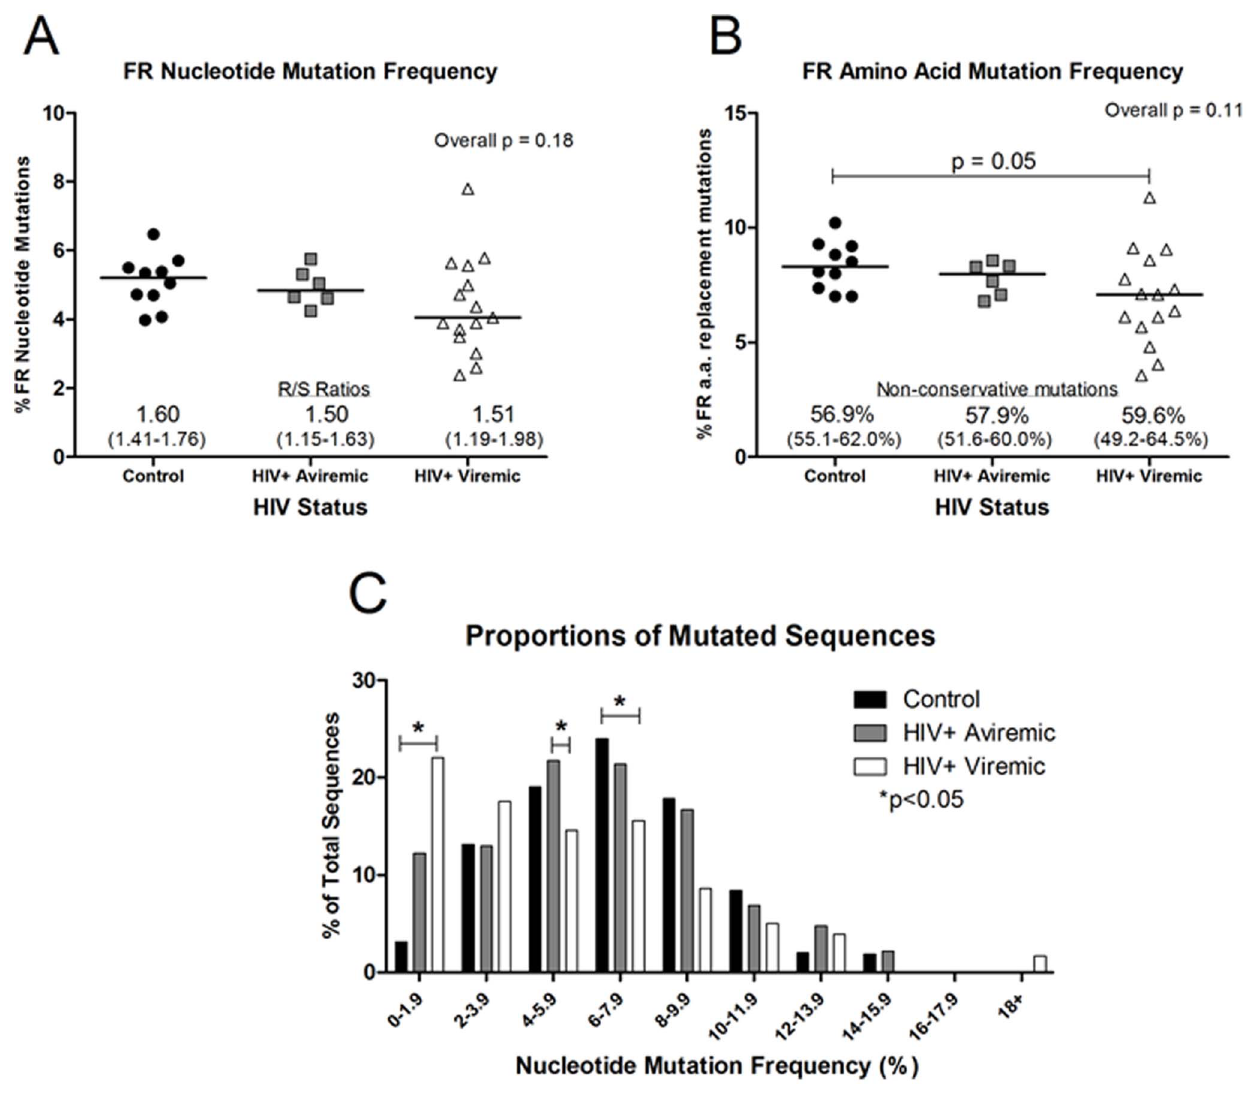
Figure 3. Amino acid mutation frequency is reduced in FR1/2/3 regions of viremic HIV-1-infected patients. The mean percent of mutated nucleotides or the mean percent of replaced amino acids was calculated for each control subject (n=10; black circles), aviremic patient (n=6; gray squares), or viremic HIV-1-infected patient (n=15; white triangles) based on the alignment of the cloned sequences with V H 3 sequences from the Vbase immunoglobulin database. The solid bar indicates the group median. A) The mean percent of mutated nucleotides in the FR1/2/3 regions. The median (and range) of R/S ratios indicates the number of amino acids replaced as a result of nucleotide mutations relative to unchanged (silent) amino acids (overall p=0.17). B) The mean percent of replaced amino acids in the FR1/2/3 regions. The median (and range) percent non- conservative mutations was calculated relative to the total number of replaced amino acid mutations (overall p=0.19). C) The proportion of sequences with low nucleotide mutation density is greater in viremic HIV-1-infected patients. The median proportion of sequences with specific nucleotide mutation density across the entire sequence is graphed by group (control=black bars, aviremic=gray bars, viremic=white bars). Overall p values 0–1.9%, p=0.02; 4–5.9%, p=0.04; 6–7.9%, p=0.04. Secondary analyses are shown on the graph. Proportions are expressed as a percentage of the total number of sequences. doi:10.1371/journal.pone.0081913.g003 nucleotides nor amino acids in CDR1/2 or FR1/2/3 correlated significantly with either plasma HIV-1 RNA levels (r = 0.46, p = 0.30) or CD4 + T cell numbers (r = 0.15, p = 0.63, data not shown).